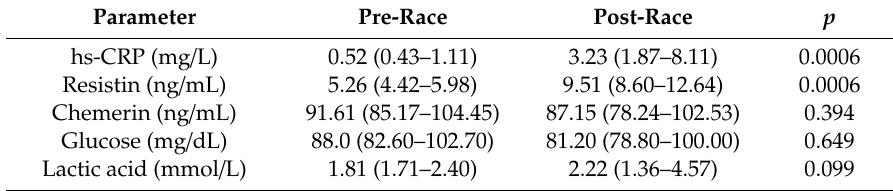
Table 3. Biochemical parameters in the serum of participants at baseline and post-race. Parameter Pre-race Post-race